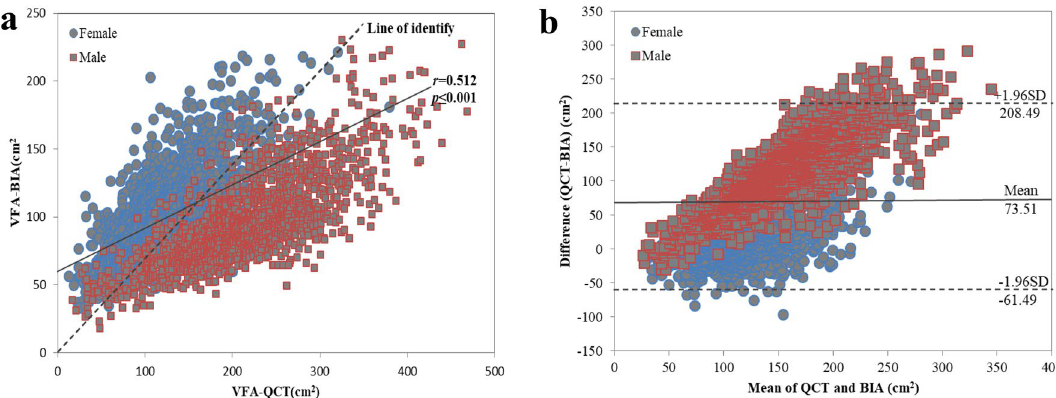
Figure 1. The association and consistency of VFA measured by QCT and BIA. ( a ) Scatter plot of VFA measured by QCT and BIA. VFA estimated by BIA had significantly positive correlation with that of the QCT method ( r = 0.512, P < 0.001). ( b ) Bland–Altman plot of difference in VFA (QCT measurement minus BIA measurement) against the mean of two measurements. The middle line denotes bias (mean difference between the two measurements), and dashed lines denote 95% limits of agreement (1.96 SD of the difference, bias: 73.51, 95% LOA: − 61.49 to